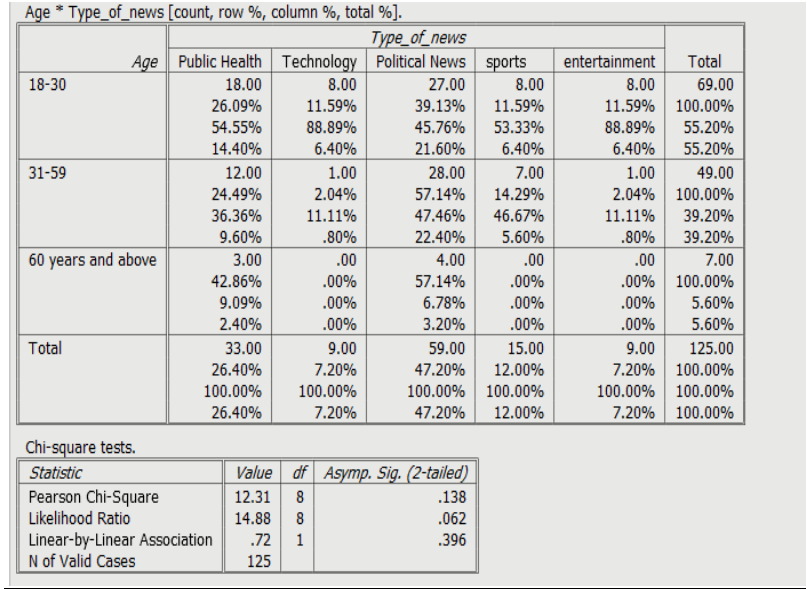
Figure 6: Cross tabulation and Chi-square between Gender v/s Type of News (Source: Authors‟